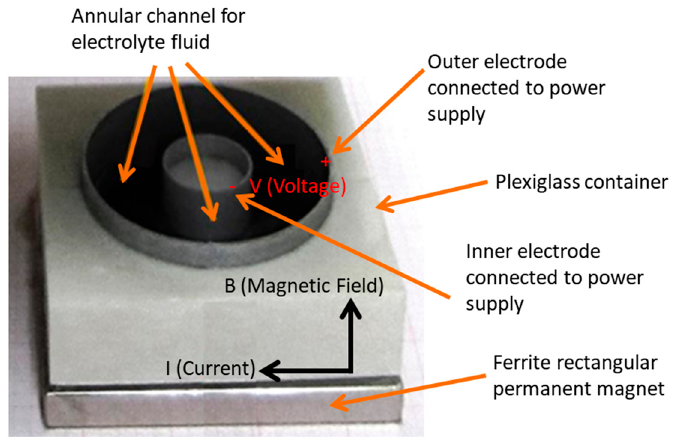
Figure 1. Geometric shape and elements of the MHD microfluidic system (MHD stirrer).